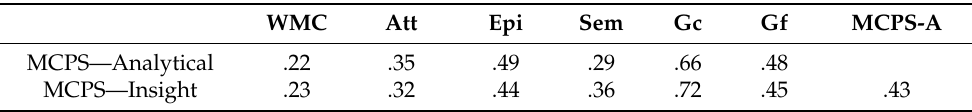
Table 6. Latent factor correlations between working memory capacity (WMC), attention control (Att),